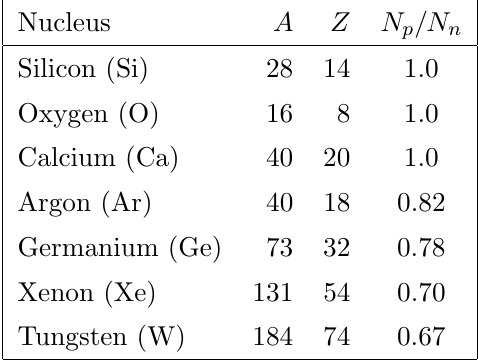
Table 2 . Composition of target nuclei. Summary of the (approximate) atomic mass A , atomic number Z and proton-to-neutron ratio N p =N n for the target nuclei considered in this work. is signi(cid:12)cantly di(cid:11)erent from the other targets, which are summarized in table 2. Note